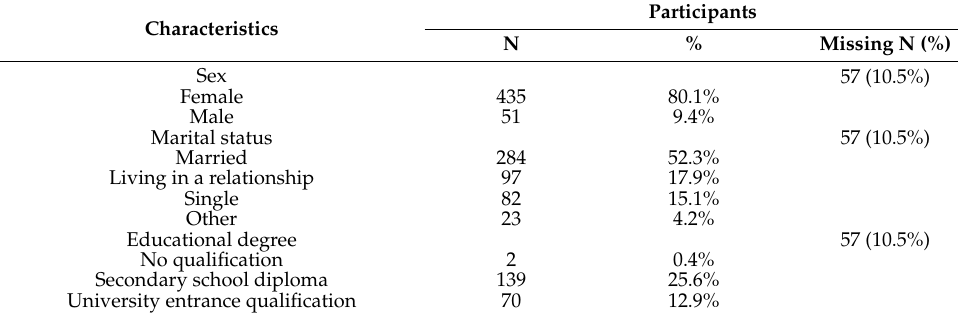
Table 1. Study sample